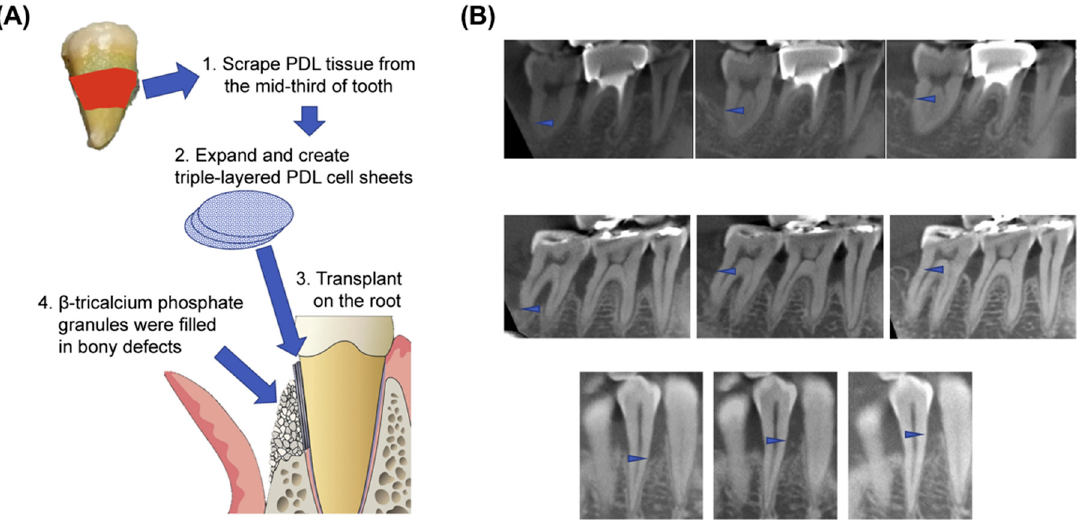
Figure 4. Periodontal tissue engineering with autologous periodontal ligament (PDL)-derived cell sheets. ( A ) Schematic diagram of the implantation of multi-layered patient-derived PDL cell sheets induced by PNIPAAm-immobilized TCPS. ( B ) Regeneration of periodontal tissues with increased bone height in representative cases. Arrowheads: the most apical part of bone defects. Reproduced with permission from [82].